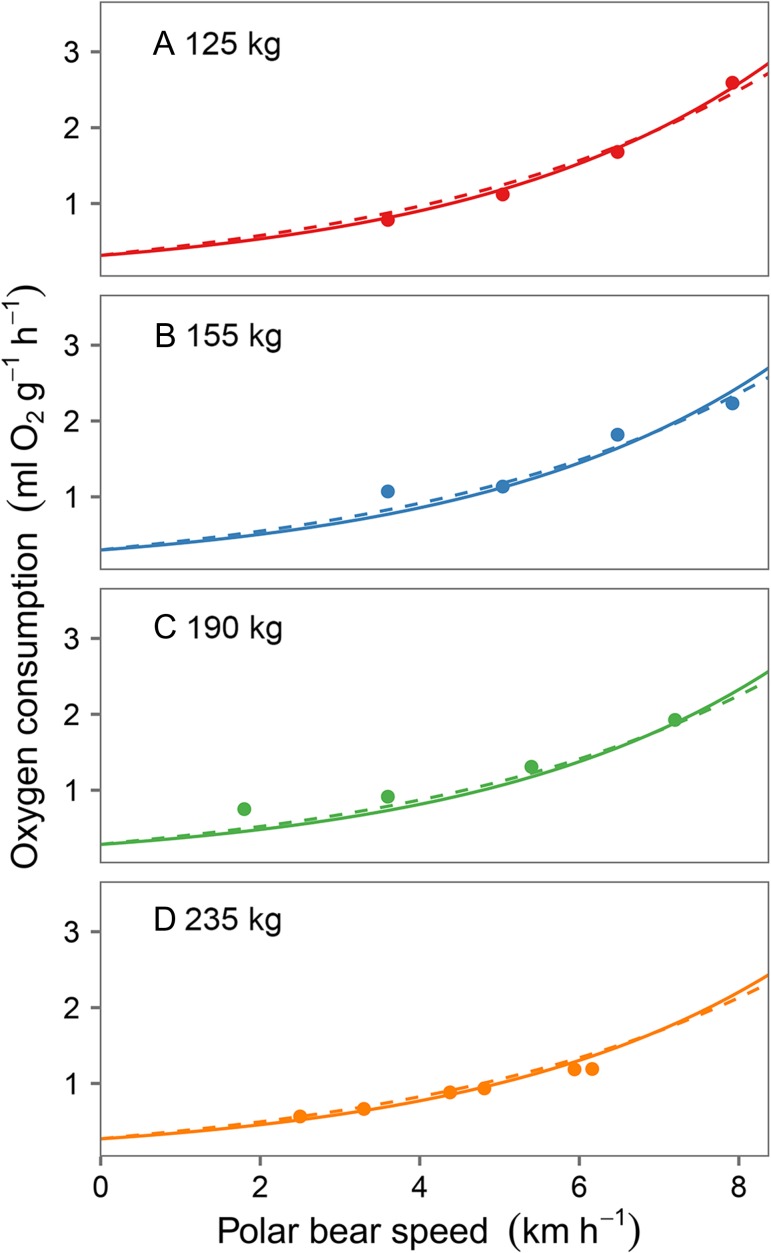
Mass-specific oxygen consumption increases with movement speed. Postural costs (y-intercept) are affected by polar bear mass according to Equation 4. The top model based on AICc was a single-exponential model (continuous lines). A double-exponential model received similar support (ΔAICc = 0.5) and made similar predictions across the range of data (dashed lines).